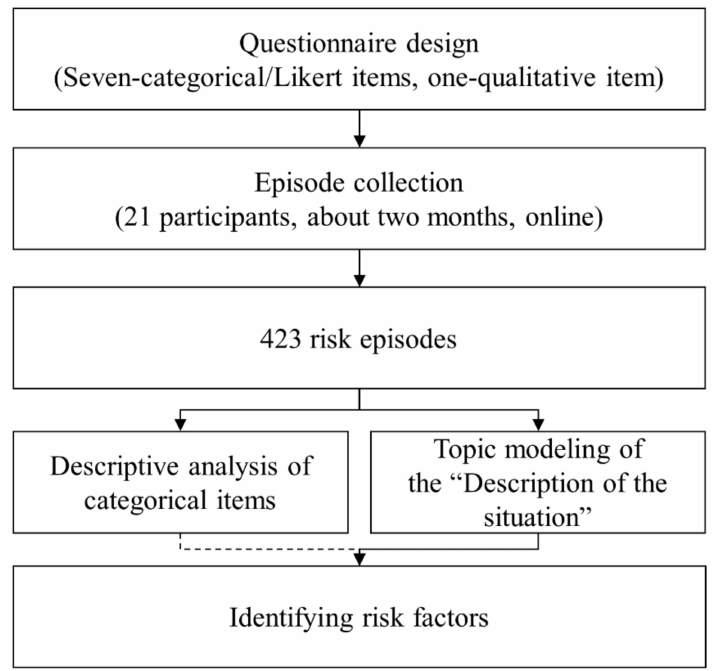
Figure 2. Overall flow of this